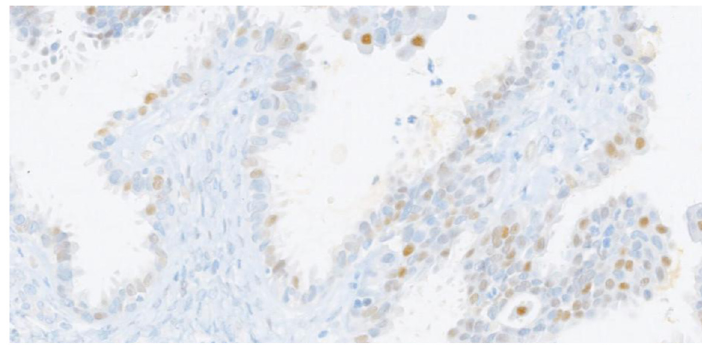
Figure 4. Wild-type immunoexpression of p53 in serous borderline tumor (SBT), original magnification